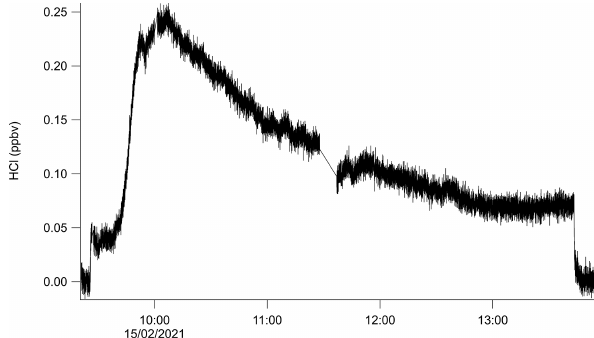
Figure 8. Demonstration of the effects of 3.0ppbv nitric acid addition to the passivated sample inlet flow at approximately